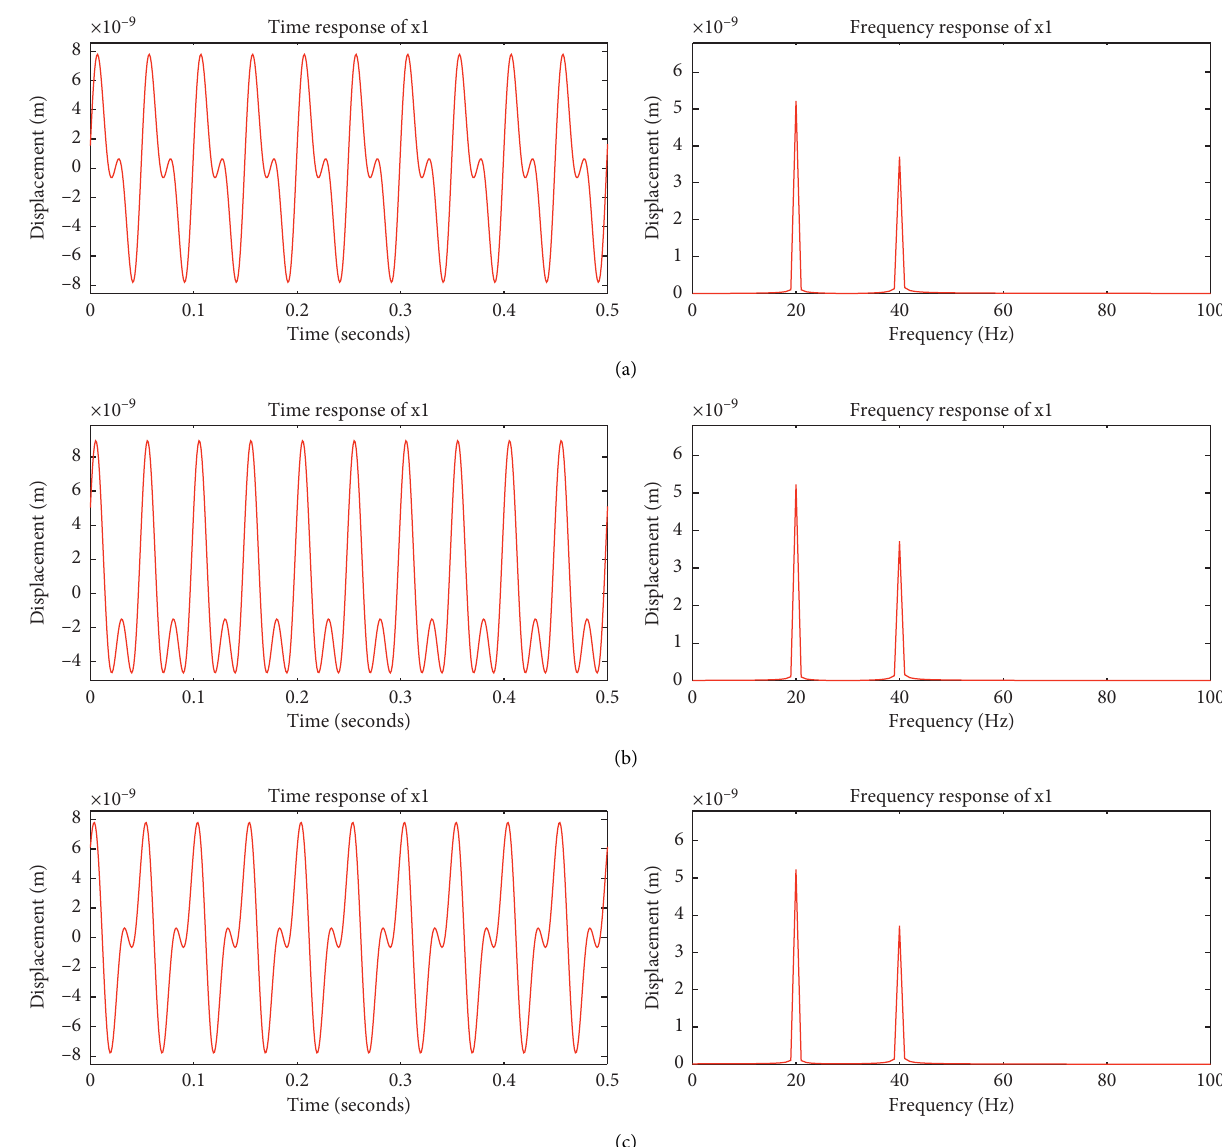
Figure 18: Effects of phase shift on the vibration response (time and frequency domains) in the radial direction x Phase � 45 ° . (c) Phase � 90 °